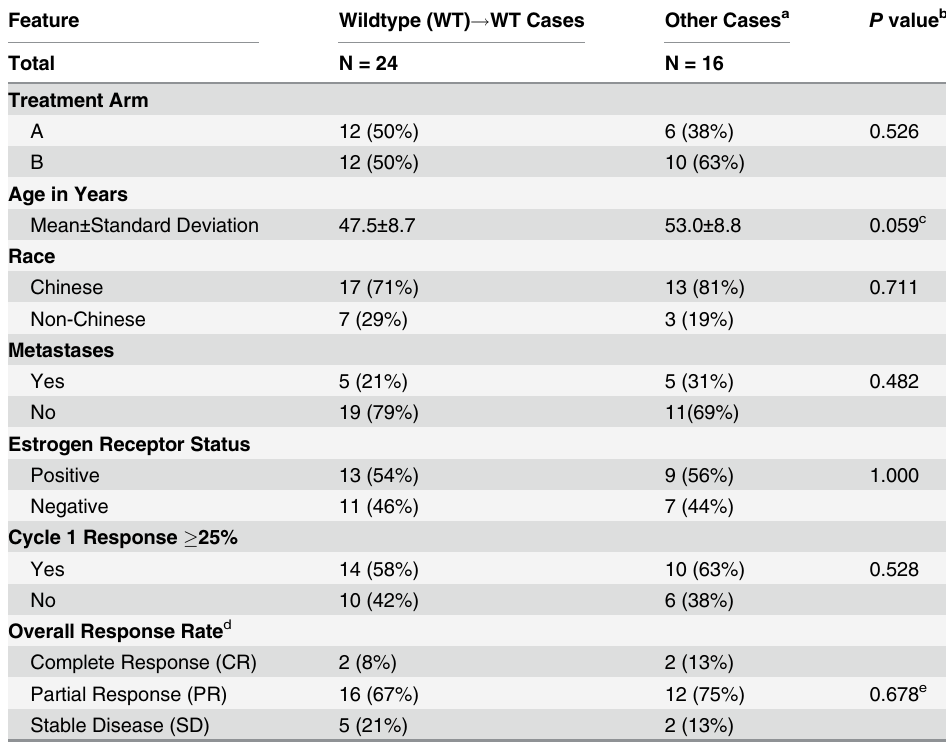
Table 2. Association of pre- and post-chemotherapy mutation patterns with clinicopathological features.